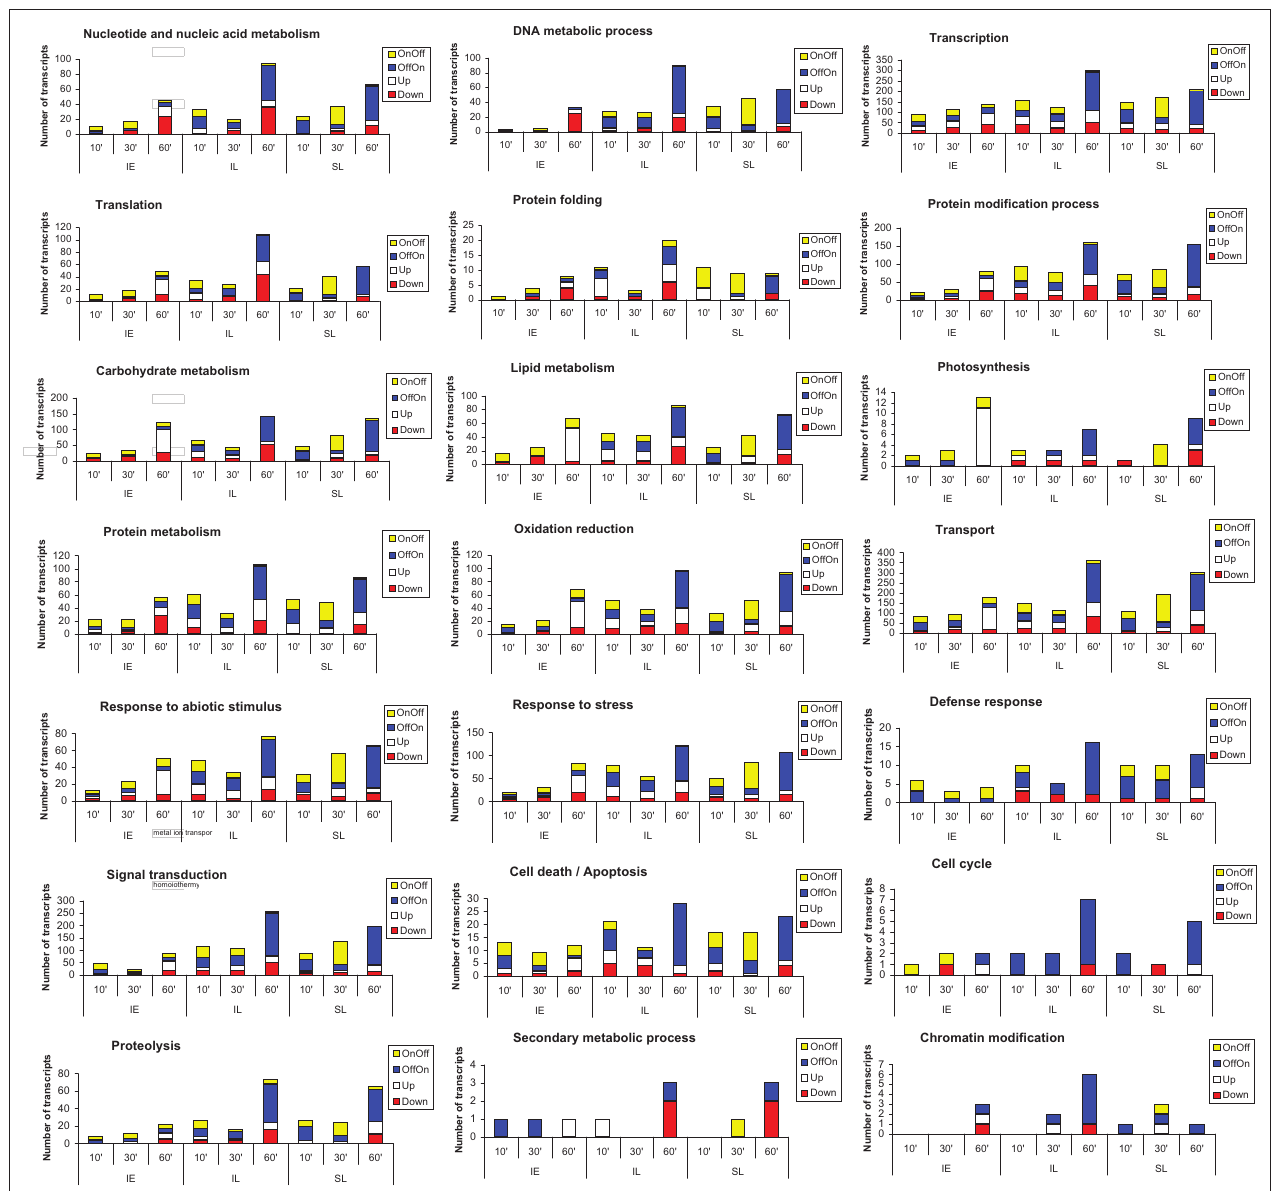
FigURe 3 | gO classification of transcripts into categories. Transcripts that were turned on (OffOn) or off (OnOff), or that were up- or down-regulated over the 1 h time course experiment were used. Transcripts that belonged to 18 major cellular processes were used for